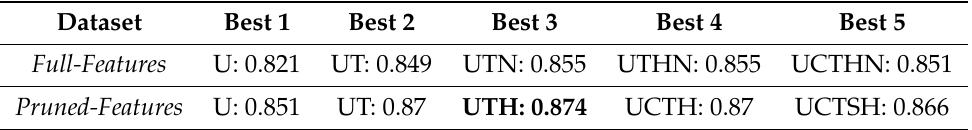
Table 6. Accuracy performance of the BBC classifiers in comparison to the different combinations of feature categories. Each column refers to the best combination for each number of combined feature categories. Apparently, the combination of U ser, T emporal and H ashtag feature categories provides the best results. However, the accuracy does not fluctuate significantly, regardless of the feature category combination that has been